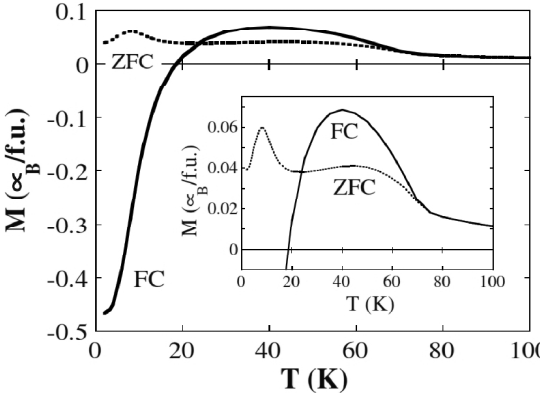
Fig. 8. FC (solid line) and ZFC (dotted line) NdMnO magnetization with an applied field H =1 3.11 kOe. Reproduced from [51] with permission from